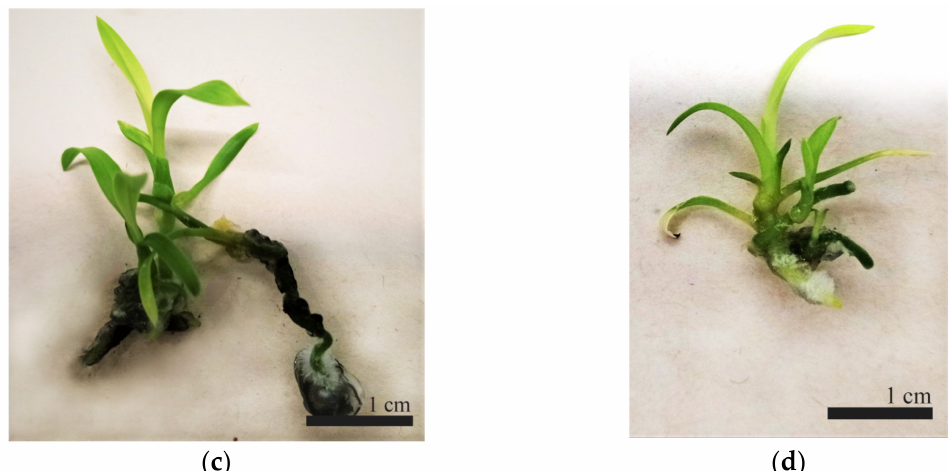
Figure 4. Influence of growth regulators on the morphometric parameters of C. erythrostylum plantlets: ( a ) 1.0 6-BAP + 0.5 NAA mg/L; ( b ) 2.0 6-BAP + 0.5 NAA mg/L; ( c ) 1.0 Kin + 0,5 NAA mg/L; ( d ) 2.0 Kin + 0.5 NAA mg/L.